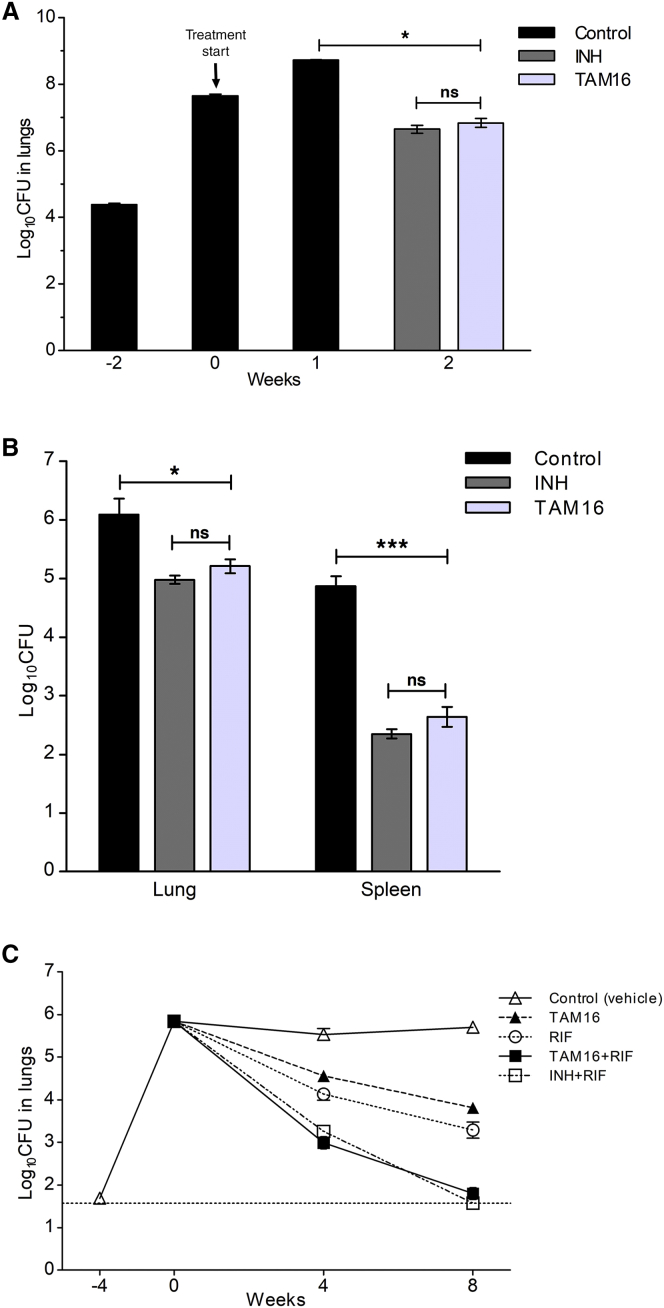
Efficacy of TAM16 in Mouse Models of TB(A) In vivo activity of TAM16 against acute TB infection in immunocompetent BALB/c mice. Data represent mean M. tuberculosis burden (log10 CFU) in the lungs of mice (n = 5 per time point) expressed as mean ± SD. Week 0 indicates CFU counts in the lungs at treatment initiation (2 weeks after infection). Drugs were administered via oral gavage 5 days/week for 2 weeks. The mice in the untreated group were moribund after 3 weeks of infection and were euthanized in accordance with institutional animal care regulations. ∗p < 0.05 by Dunnett’s multiple comparison tests, as compared to the untreated (vehicle-only) control group; ns, no statistical significance.(B) Efficacy of TAM16 in reducing M. tuberculosis burden in chronically infected immunocompetent mice after 4 weeks of treatment. Treatment was initiated 27 days after infection, and drugs were administered once daily via oral gavage for 5 days/week for 4 weeks. Data show the bacterial loads (mean log10 CFU ± SD) in the lungs and spleen of the infected mice (n = 5 per group). ∗p < 0.05 and ∗∗∗p < 0.001 by pairwise multiple comparison procedures (Tukey test); ns, no statistical significance.(C) Efficacy of TAM16 administered in combination with anti-TB drug rifampicin (RIF) in chronically infected BALB/c mice. Treatment was initiated 28 days after infection, and drugs were administered once daily via oral gavage (5 d/wk) for 4 and 8 weeks. Data represent mean M. tuberculosis burden (log10 CFU) in the lungs of the infected mice (n = 6 for vehicle-only control group and n = 7 for each treatment group) after 4 and 8 weeks of therapy (mean ± SEM). In combination studies, TAM16 and isoniazid (INH) were administered 1 hr following prior administration of RIF. Dotted horizontal line indicates the limit of detection.See also Figure S5 and Table S7.